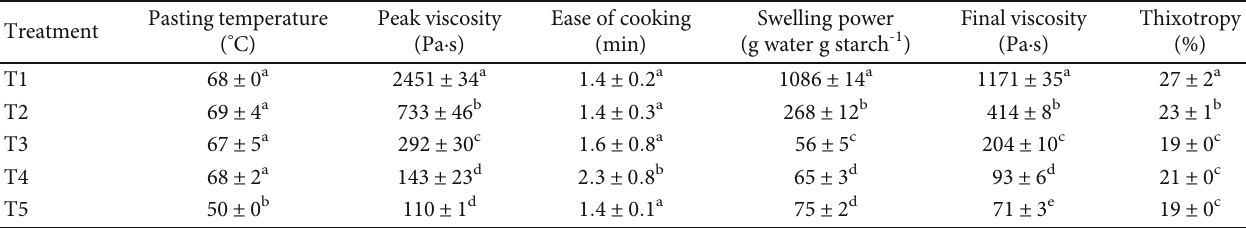
Table 2: E ff ect of blending wheat and ackee aril fl our on dough pasting properties. Treatment